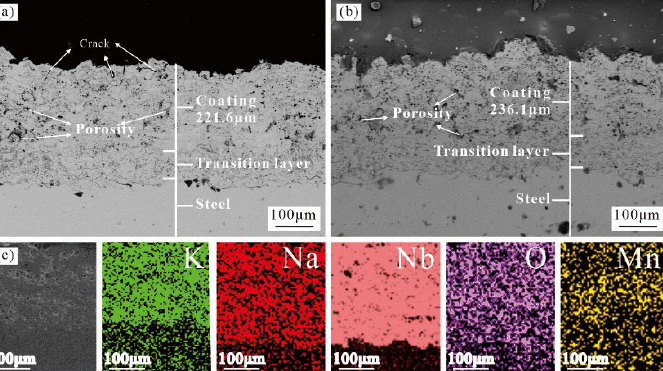
Figure 4. ( a ) Cross-sectional morphology of KNN coating. ( b ) Cross-sectional morphology of KNMN coating. ( c ) EDS surface scan of KNMN coating. Table 2. Element contents in the coatings.